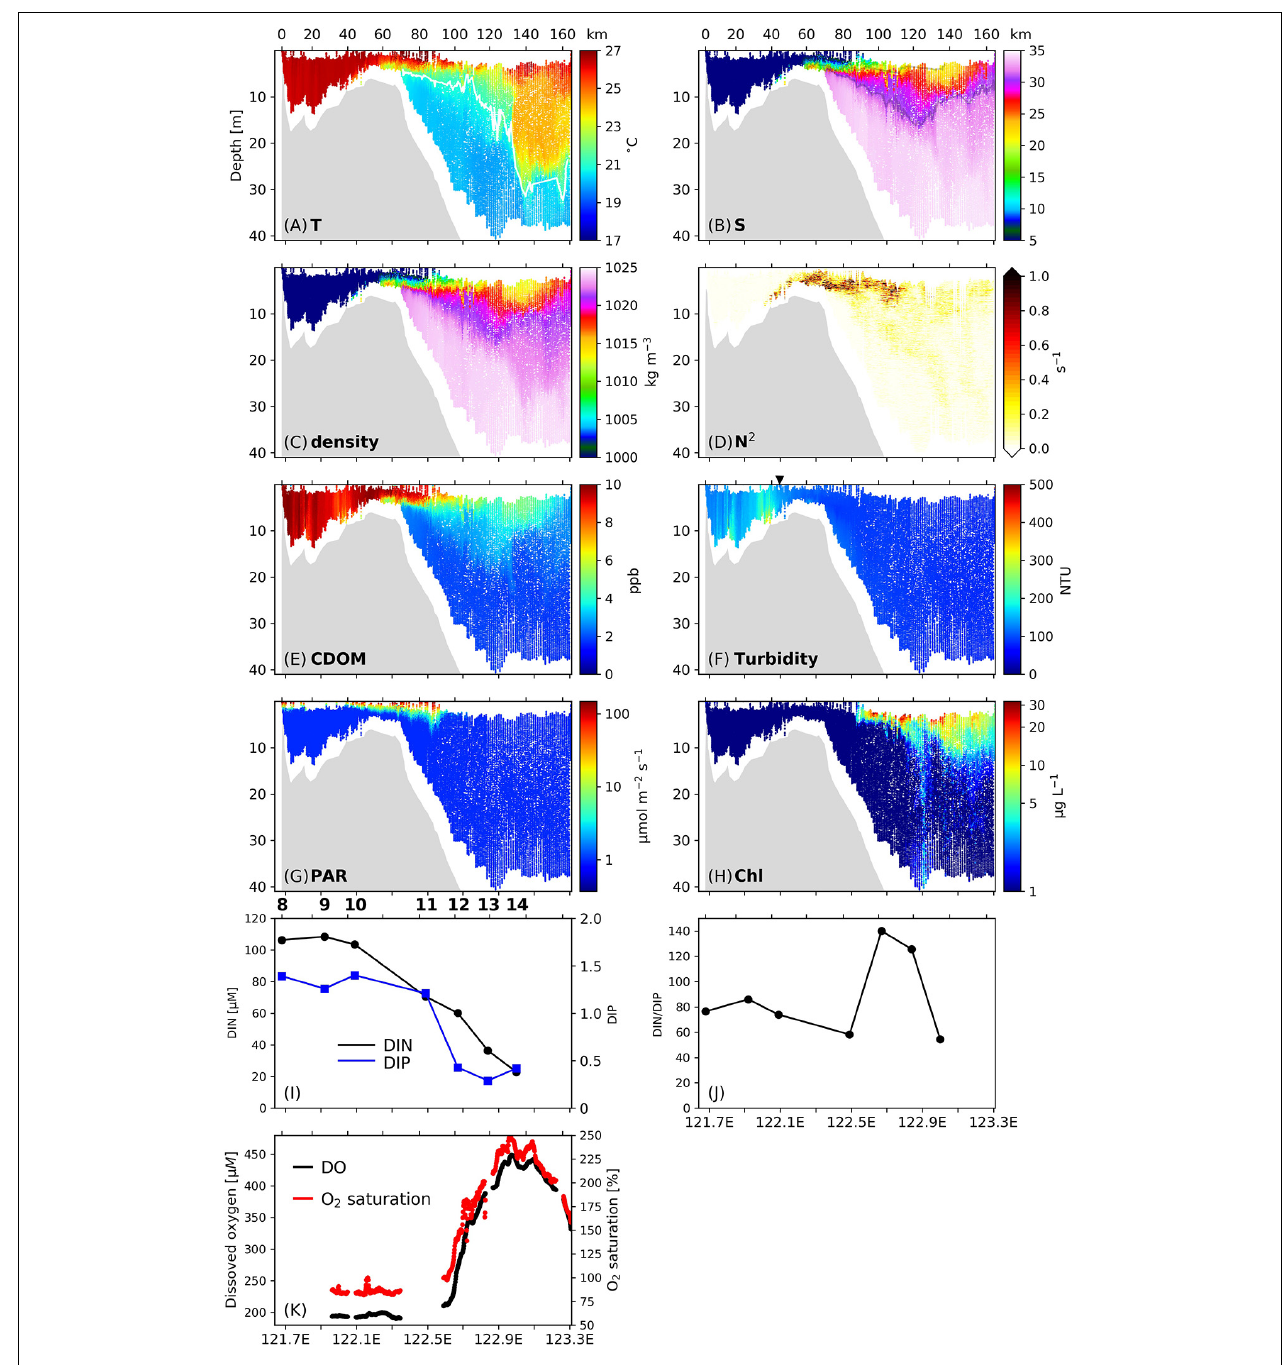
FIGURE 4 | (A–G) Vertical profiles of (A) temperature, (B) salinity, (C) density, (D) stratification frequency ( N 2 ), (E) CDOM concentrations, (F) turbidity, (G) PAR and (H) Chl concentrations along Transect C2. Numbers on the upper x -axis denotes the distance (unit: km) from the inshore boundary of the transect. The isotherm of 21 ◦ C is denoted by the white line in (A) , and isohalines of 23 and 31 are denoted by the gray lines in (B) . The triangle above (F) labels the release location of the surface drifters. (I) Surface DIN (black line) and DIP (blue line) concentrations along C2. (J) Surface ratio of DIN to DIP along C2. (K) Surface dissolved oxygen (DO) concentrations (black dots) and oxygen saturation (red dots) along C2. Stations are labeled on top of (I,J) .